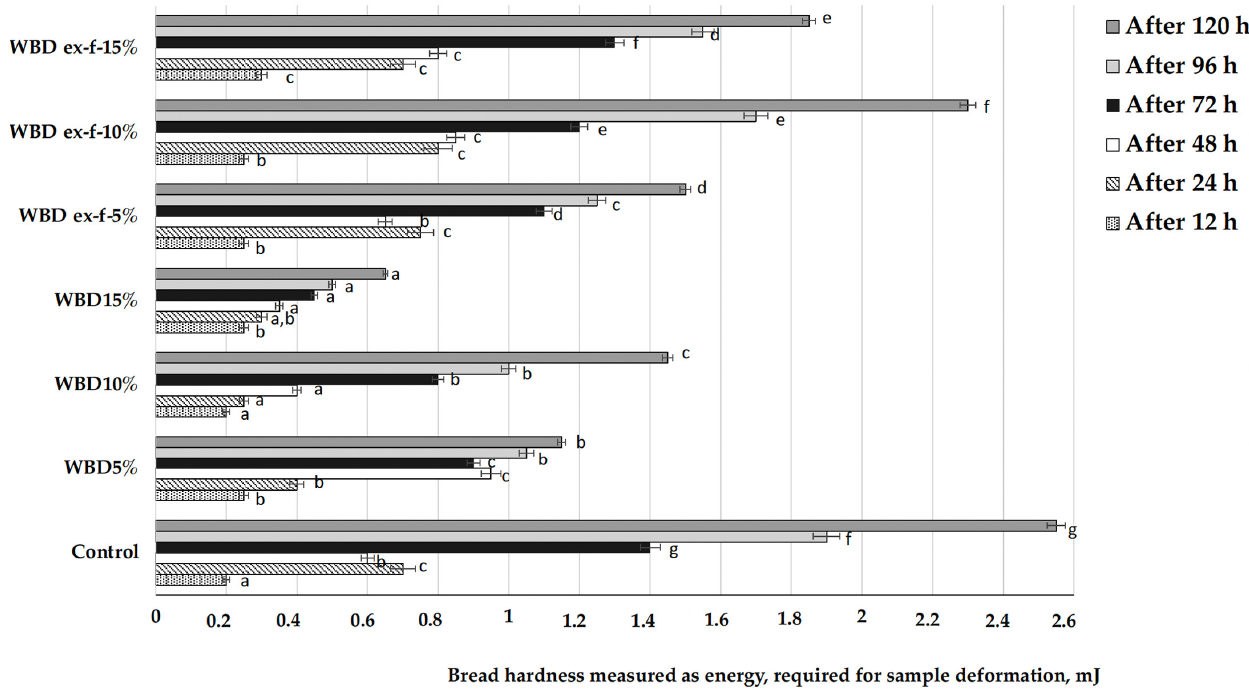
Figure 2. Changes of bread firmness during storage in plastic packaging at room temperature (data expressed as mean values ( n = 3) ± standard deviation (SD); a–g Mean values within a column with different letters are significantly different ( p ≤ 0.05)). The control bread was produced without wheat bran; WB5%, WB10%, WB15%—bread produced with 5%, 10%, and 15%, respectively, untreated wheat bran; WB ex-f-5%, WB ex-f-10%, WB ex-f-15%—bread produced with 5%, 10%, and 15%, respectively, extruded fermented wheat bran.